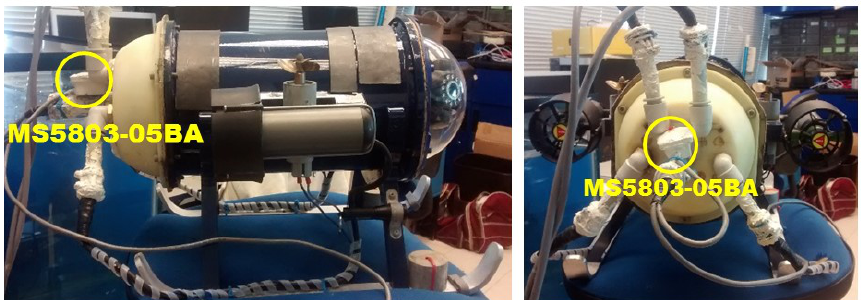
Figure 17. Location Sensor